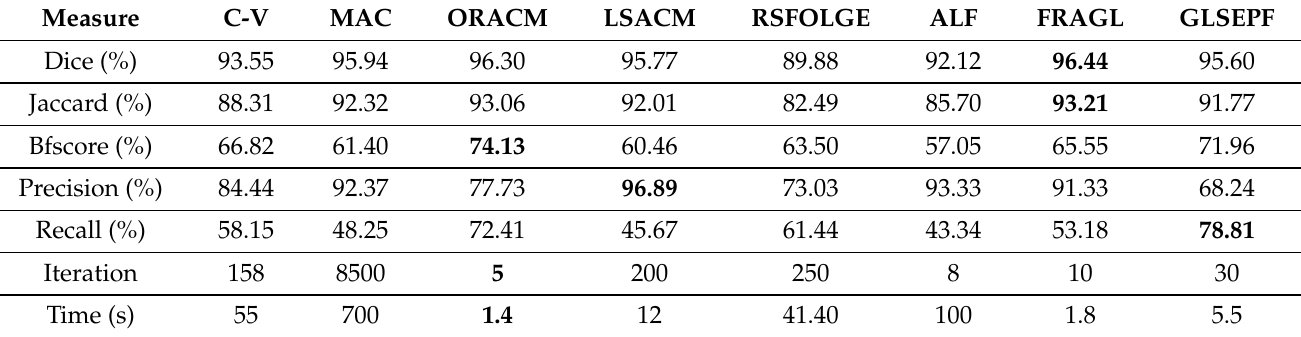
Table 3. Detailed evaluation of seven metrics based on COVID-19 CT